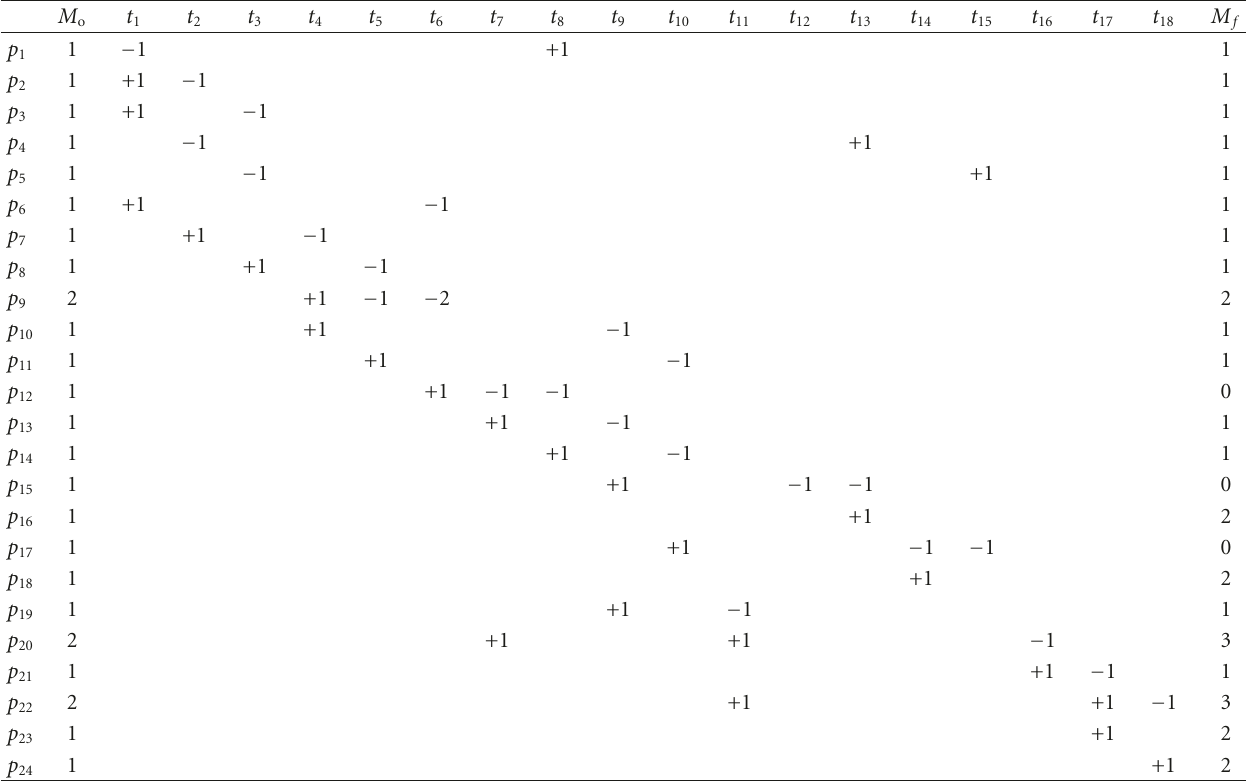
Table 3: Initial and final